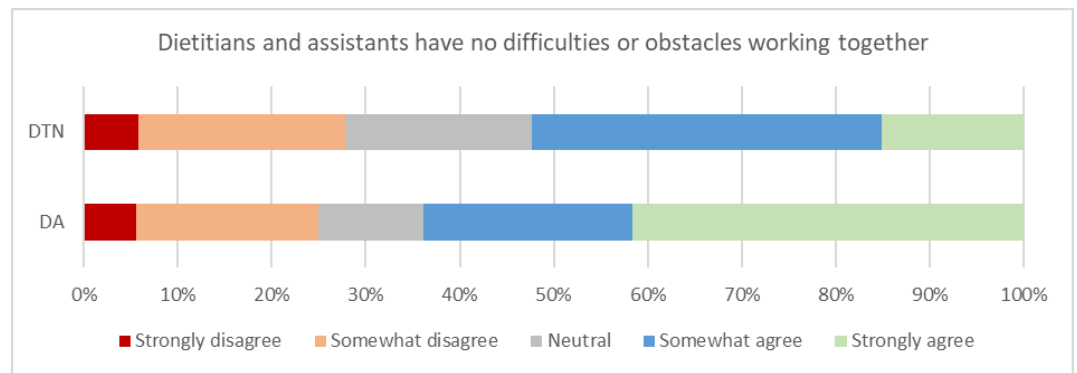
Figure 4. Dietitians’ (DTN) ( n = 86) * and dietitian assistants’ (DA) ( n = 36) * opinion regarding no difficulties or obstacles working together. * 1 dietitian and 1 dietitian assistant did not respond to this question.